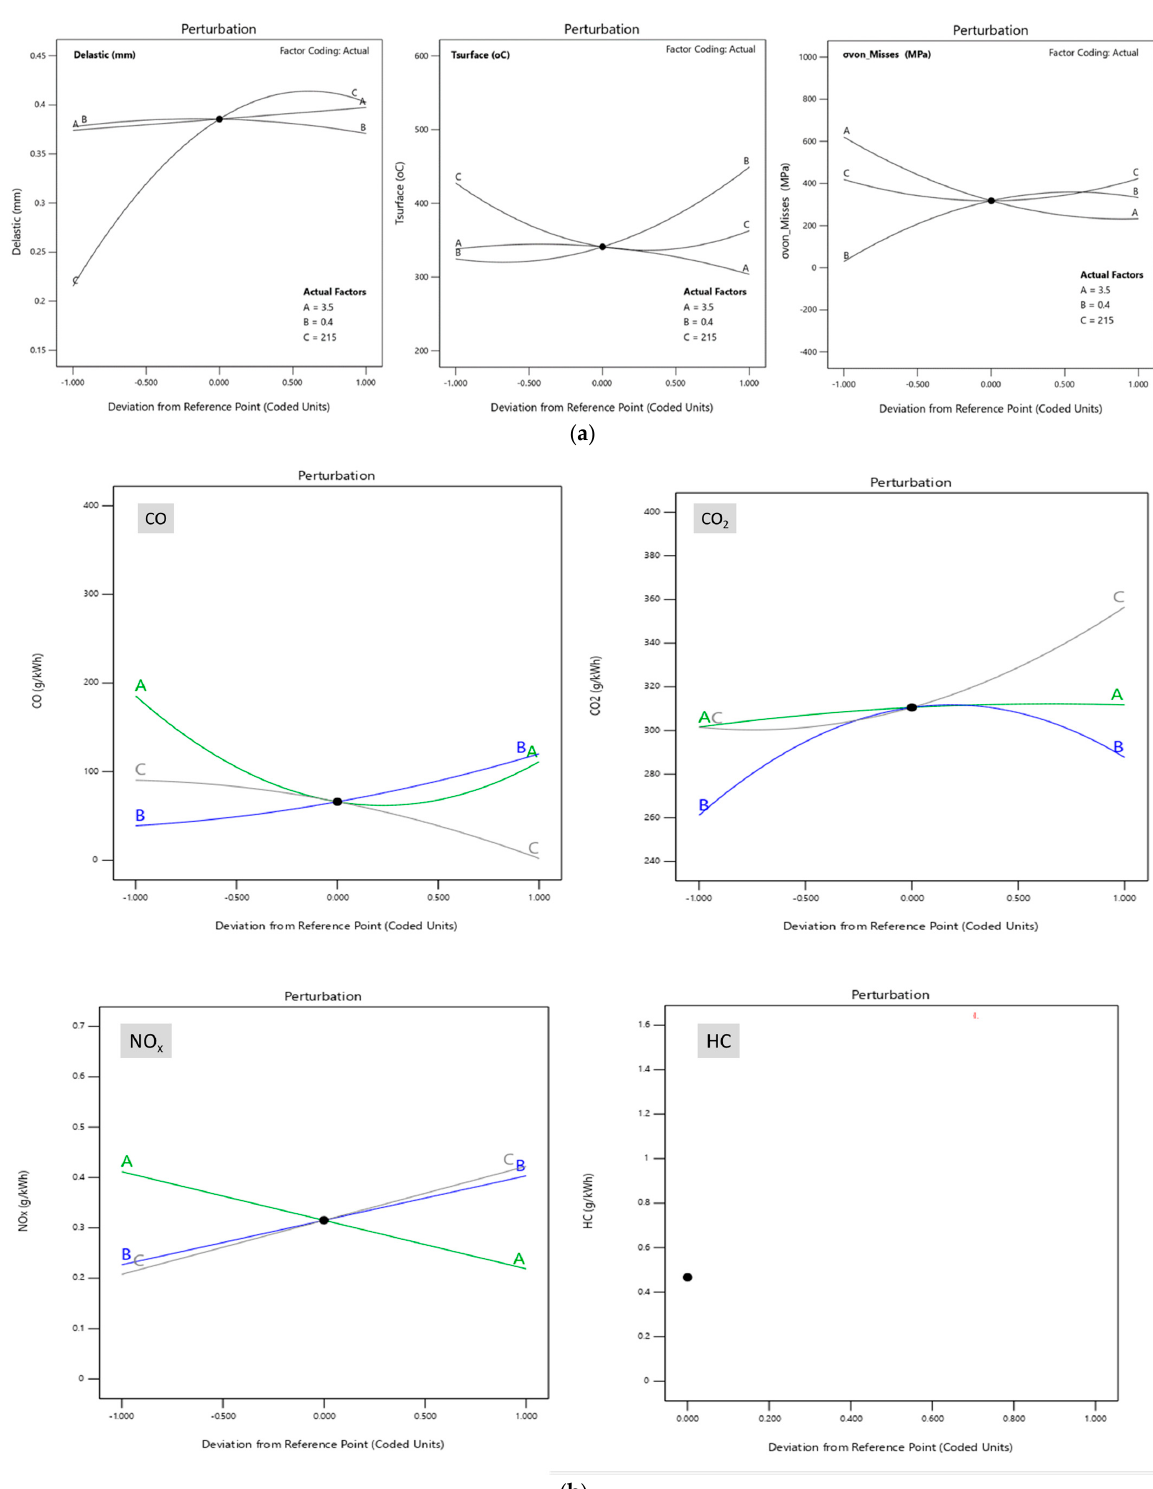
Figure 11. Box–Cox plot for power transform:( a ) elastic response, ( b )emission response.